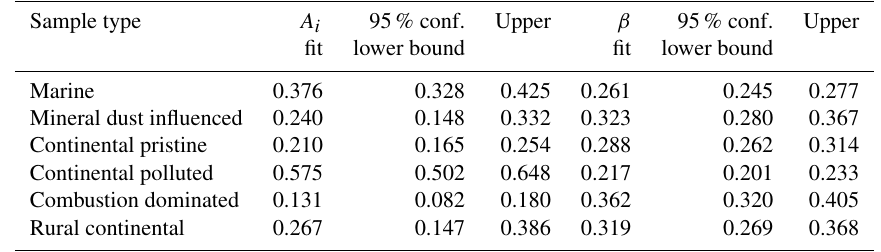
Table 6. Empirically fitted parameters of Eq. (6), (cid:49)T ( t ) = − A i t β , with 95% confidence bounds for the fitting parameters. Sample type A i 95% conf. Upper